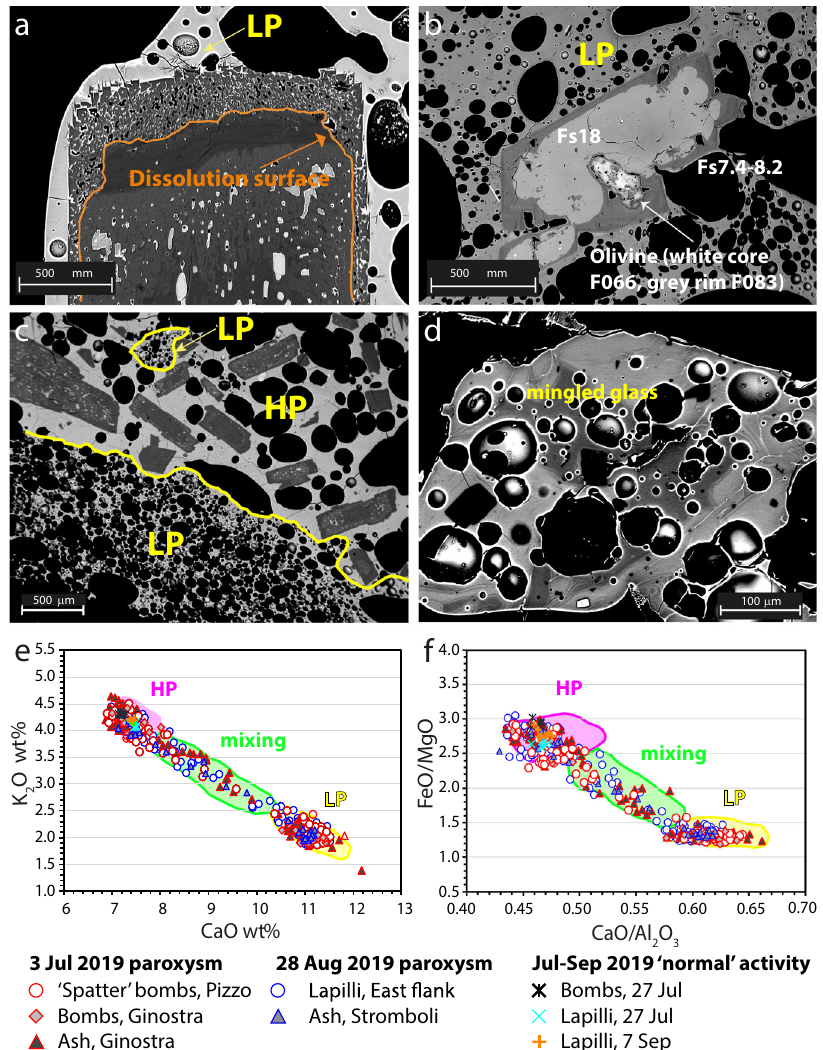
Fig. 5 Petrographic and compositional features of minerals and glassy matrix in juvenile products of both paroxysms. a – d Backscattered images of minerals and groundmasses showing disequilibrium events evidenced by dissolution surfaces and crystal rims with variable textures and compositions: ( a ) corroded crystal of zoned plagioclase with a spongy textured corona; ( b ) clinopyroxene with Fe-rich corroded core (Fs18) and Fe-poor euhedral rim (Fs7.4-8.2), including a partially resorbed olivine (Fo66) with Mg-rich rim; ( c ) sharp contact between LP (dark-gray) and HP (light-gray) glasses in 3 July products; ( d ) highly mingled glass in 28 August products. e , f Chemical composition of glassy matrices plotted in CaO vs. K 2 O and CaO/Al 2 O 3 vs. FeO/ MgO diagrams. The compositional fi eld of HP, LP, and mixed HP-LP products that erupted in the past two decades are reported for comparison (published 10,13,19,69 and unpublished